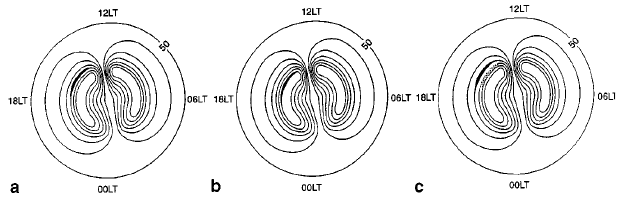
Fig. 14a–c. Schematic representation of the evolution of the LPJ and its possible e(cid:128)ect for the formation of an isolated density structure bounded by two regions of recently